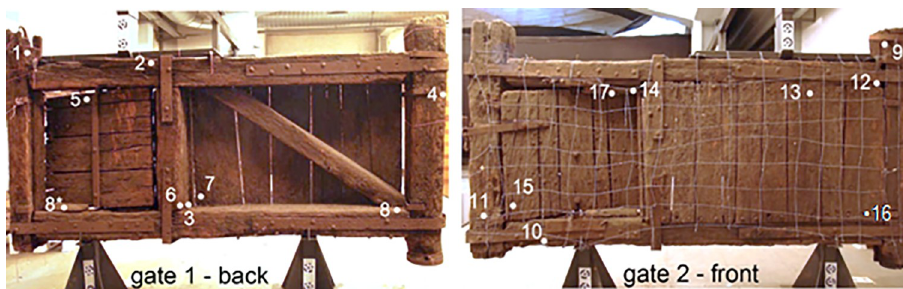
Fig 1. Images of the two canal lock gates. Numbers and points represent the sampling points for the chemical and biological analyses.